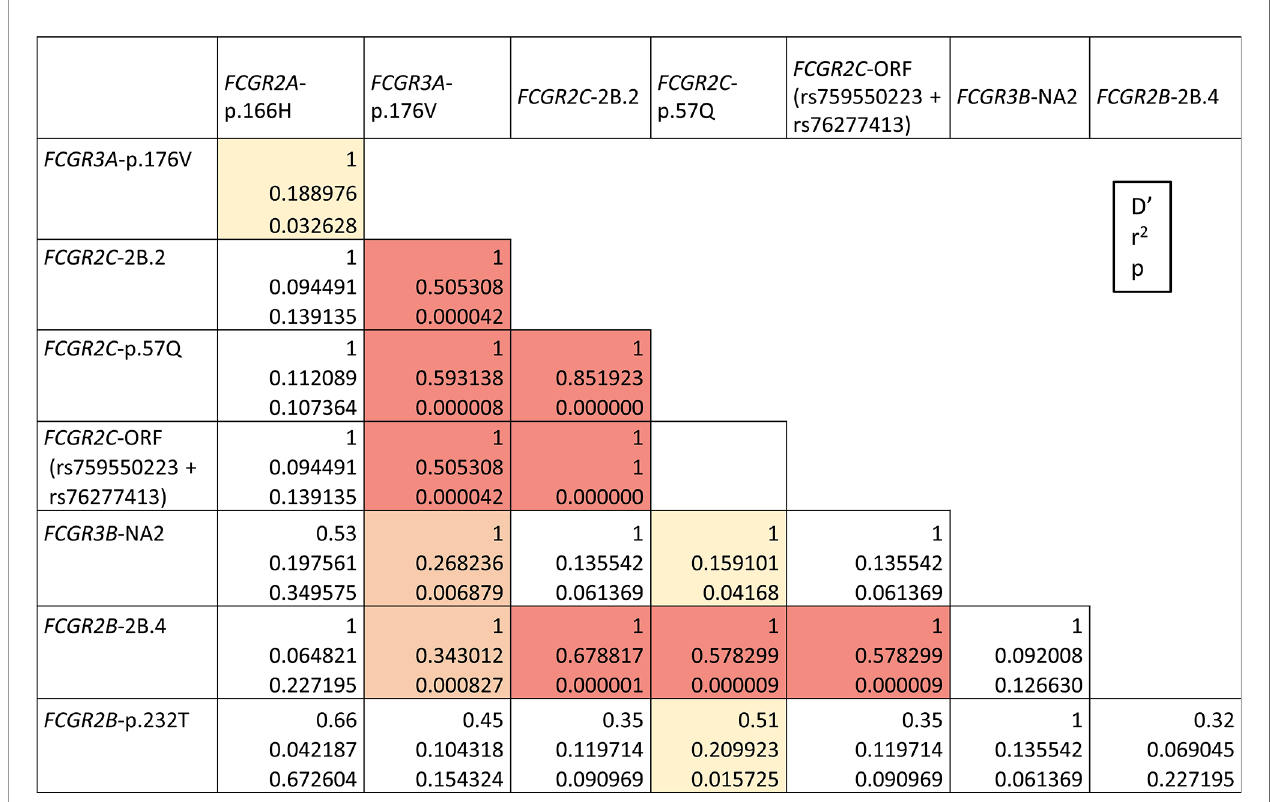
FIGURE 4 | FCGR functional variants linkage disequilibrium in highlands Ecuadorians (Quito and Cuenca, N=35). LD combinations with p<0.0001 are highlighted in red; other statistically signi fi cant LD combinations are highlighted in orange (p<0.01) or yellow (p<0.05). All shown LDs are positive. Only individuals without CNV in the FCGR locus are analysed here. Combined SNP-CNV analysis is shown in Supplementary Tables 3 and 4 .